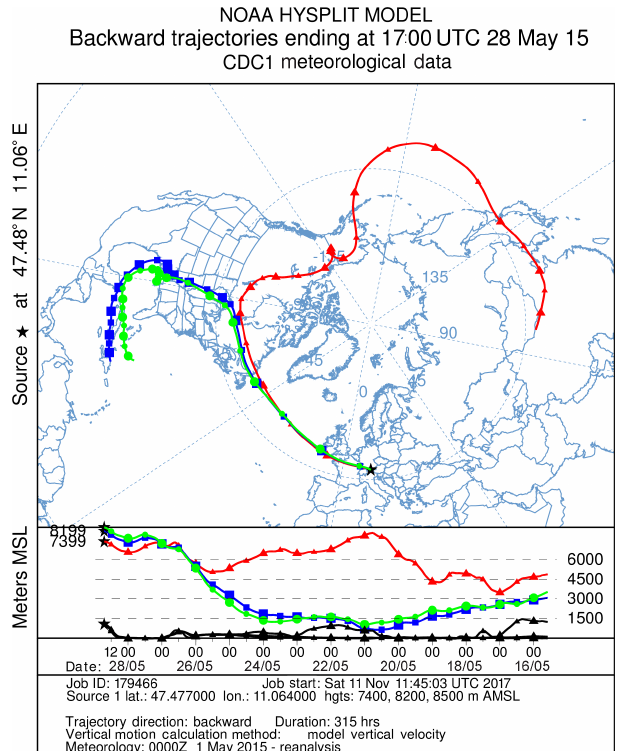
Figure 11. Selected HYSPLIT 315h backward trajectories start- ing above Garmisch-Partenkirchen on 28 May 2013 at 17:00UTC (18:00CET) for three relevant altitudes in the high-ozone ozone range of Fig. 12; the black curves at the bottom of the vertical cross section mark the ground levels for each trajectory. The mountains on 22 May (Alaska) and 16 May (China) belong to the red trajec-